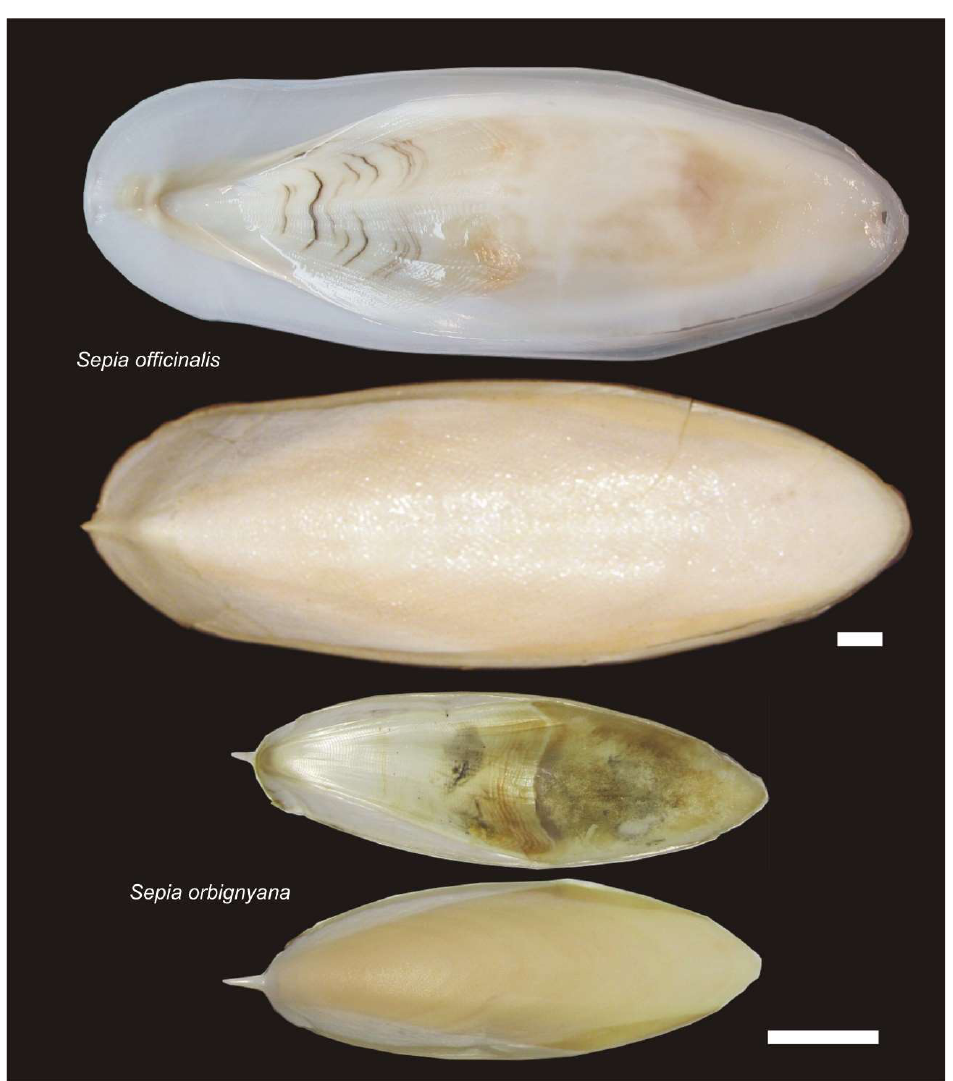
Figure 2. Cuttlebones of specimen of Sepia officinalis (SP-07) and S. orbignyana (SP-11) studied in this work, observed in ventral ( up ) and dorsal view ( down ). Scale bar 1 cm. Sepia specimens were obtained in fisheries and their origin was the southern Spanish coast.